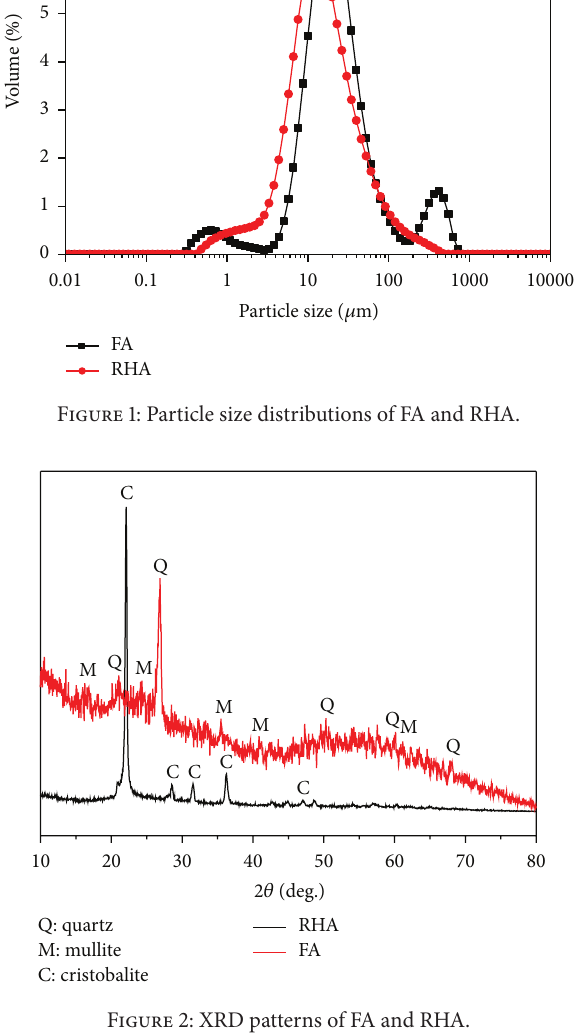
Figure 2: XRD patterns of FA and RHA.